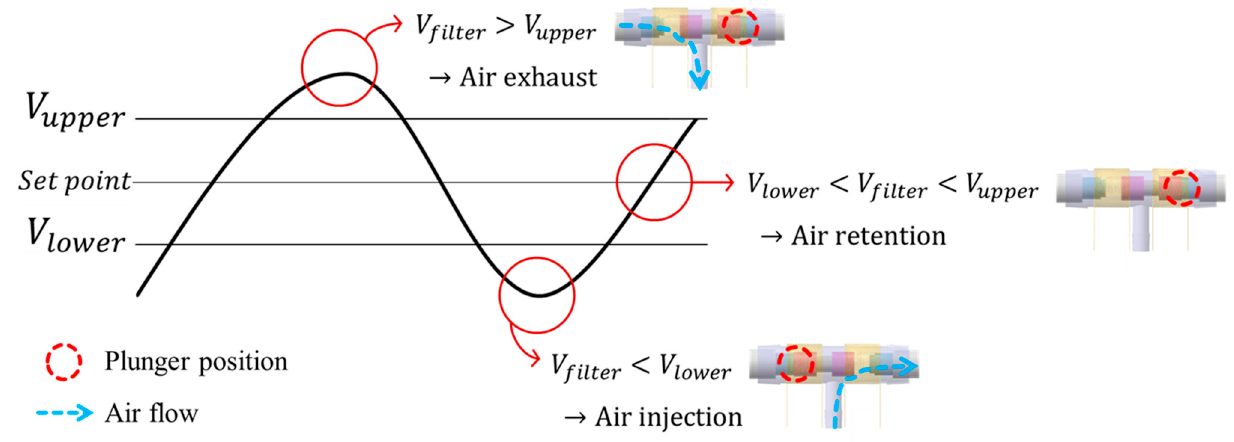
Figure 12. Description of operation by the hysteresis control algorithm.